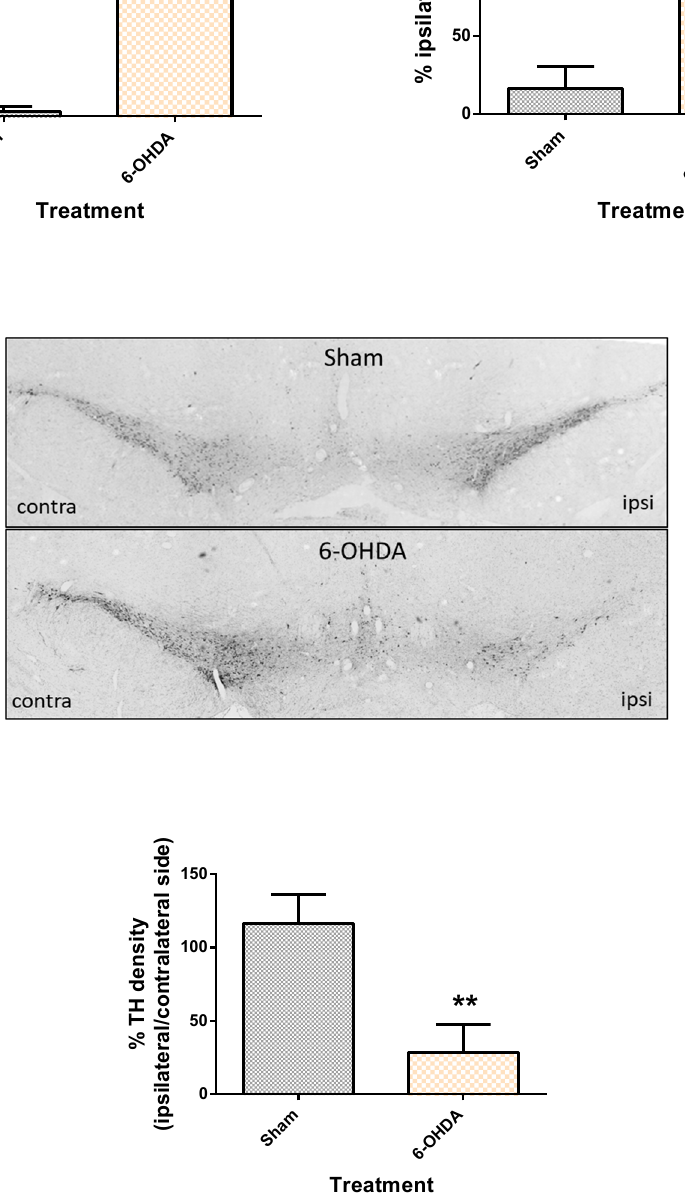
Figure 1. Comparison of motor function and dopaminergic cell loss between control and 6-OHDA groups. Apomorphine induced rotation test ( A ), Cylinder test ( B ) and TH density ( C ) between the sham and 6-OHDA group. Contra = contralateral and ipsi = ipsilateral. Data represent mean ± S.D of at least 5 rats in each group. (* indicates p value < 0.05 and ** p < 0.01, using Mann–Whitney